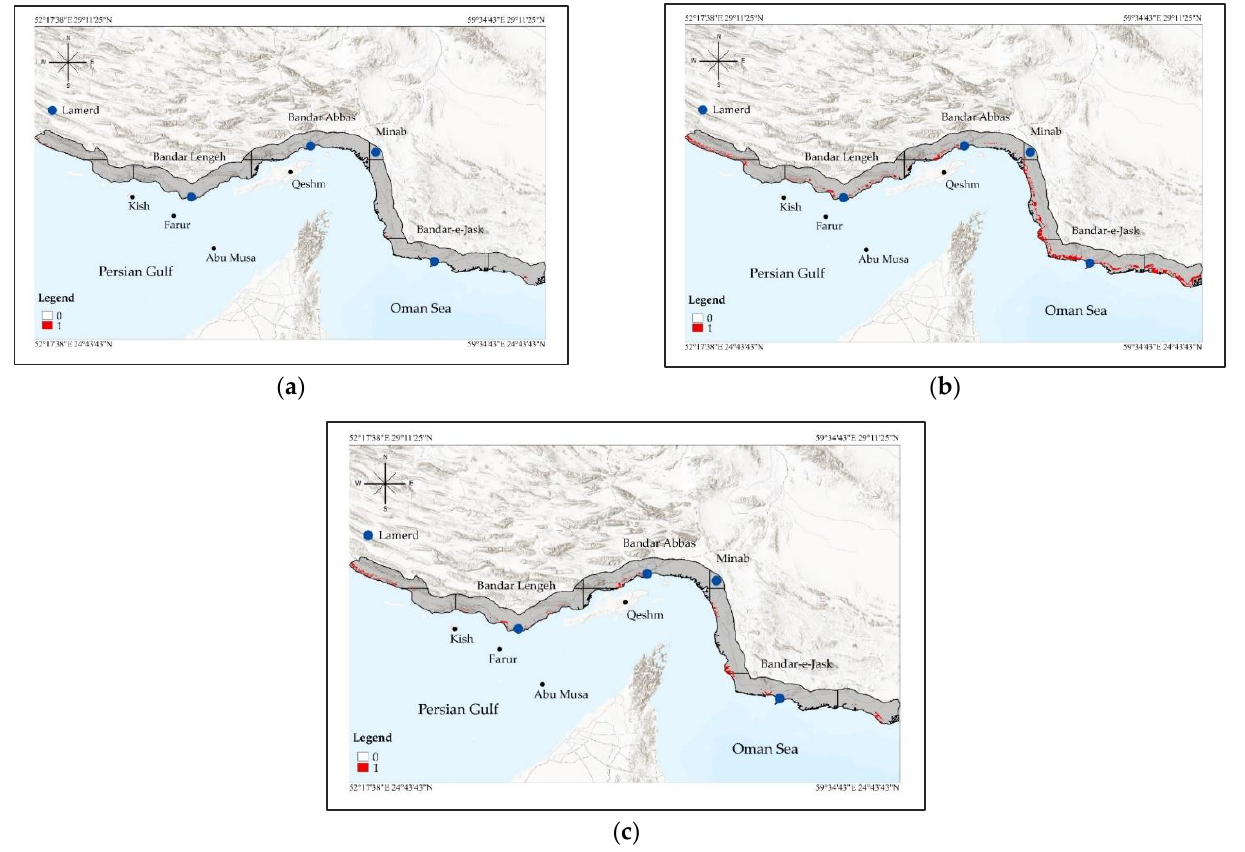
Figure 4. Results of Boolean modelling based on three modes of ( a ) conservative, ( b ) minimization, and ( c ) optimization.